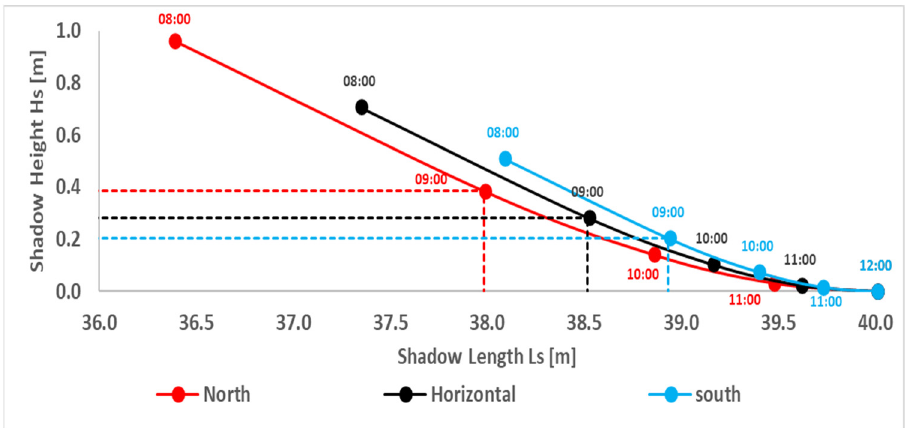
Figure 9. Shadow variation on adjacent collectors for horizontal, south-facing and north-facing planes; β = 25 ◦ , ε = 5 ◦ , φ = 32 ◦ N, H = 2.12 m, L = 40 m, December